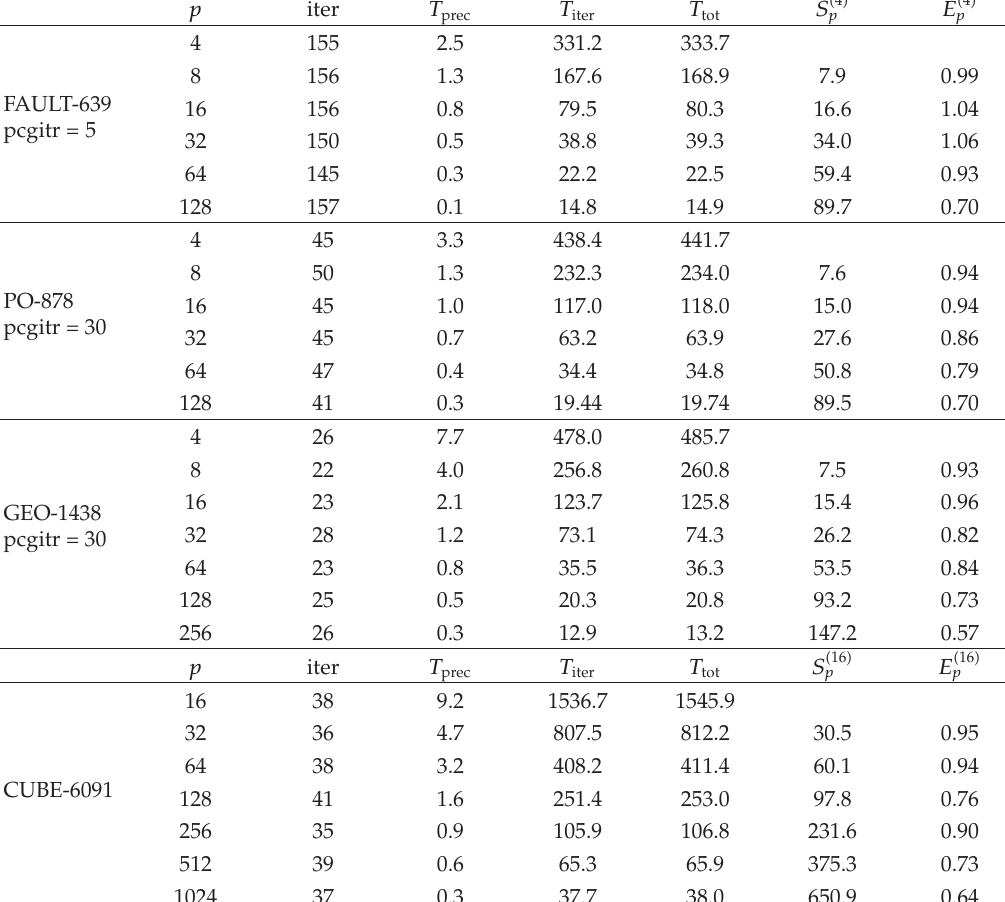
Table 6: Number of iterations, timings, and scalability of LOBPCG- hypre preconditioned by Parasails.